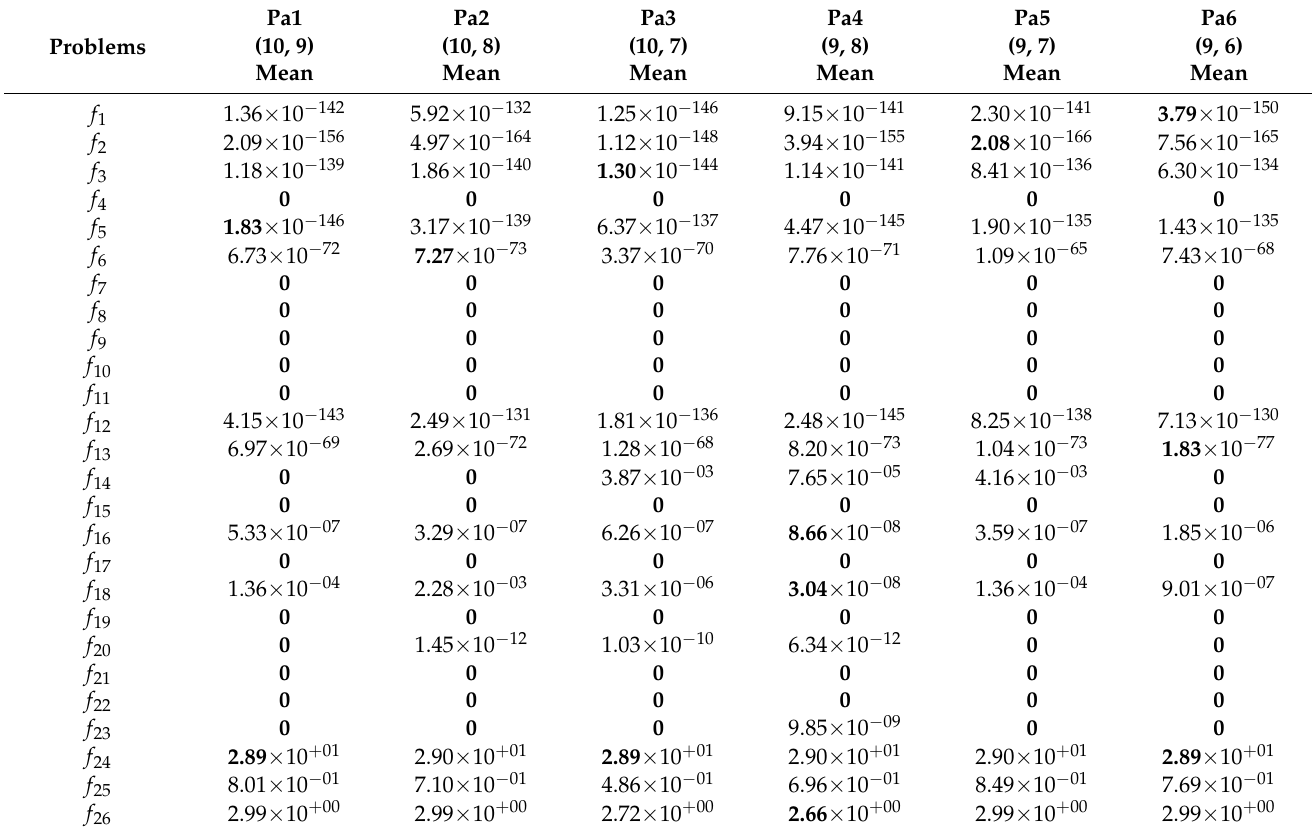
Table 2. Results of the parameter analysis of DPTCFA ( N 0 = 10 and N 0 =